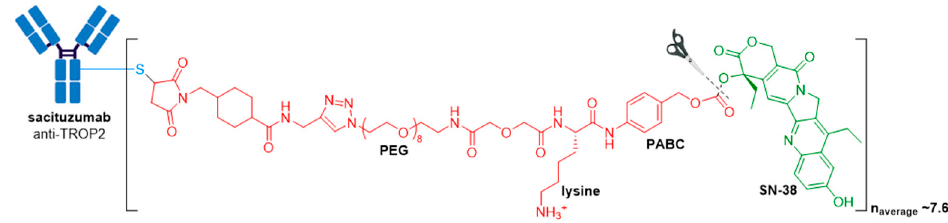
Figure 12. Structure of Trodelvy ® (sacituzumab govitecan-hziy). The antibody is shown in blue, and chemical structures for linker and payload are in red and green, respectively. PEG, polyethylenegly- col.